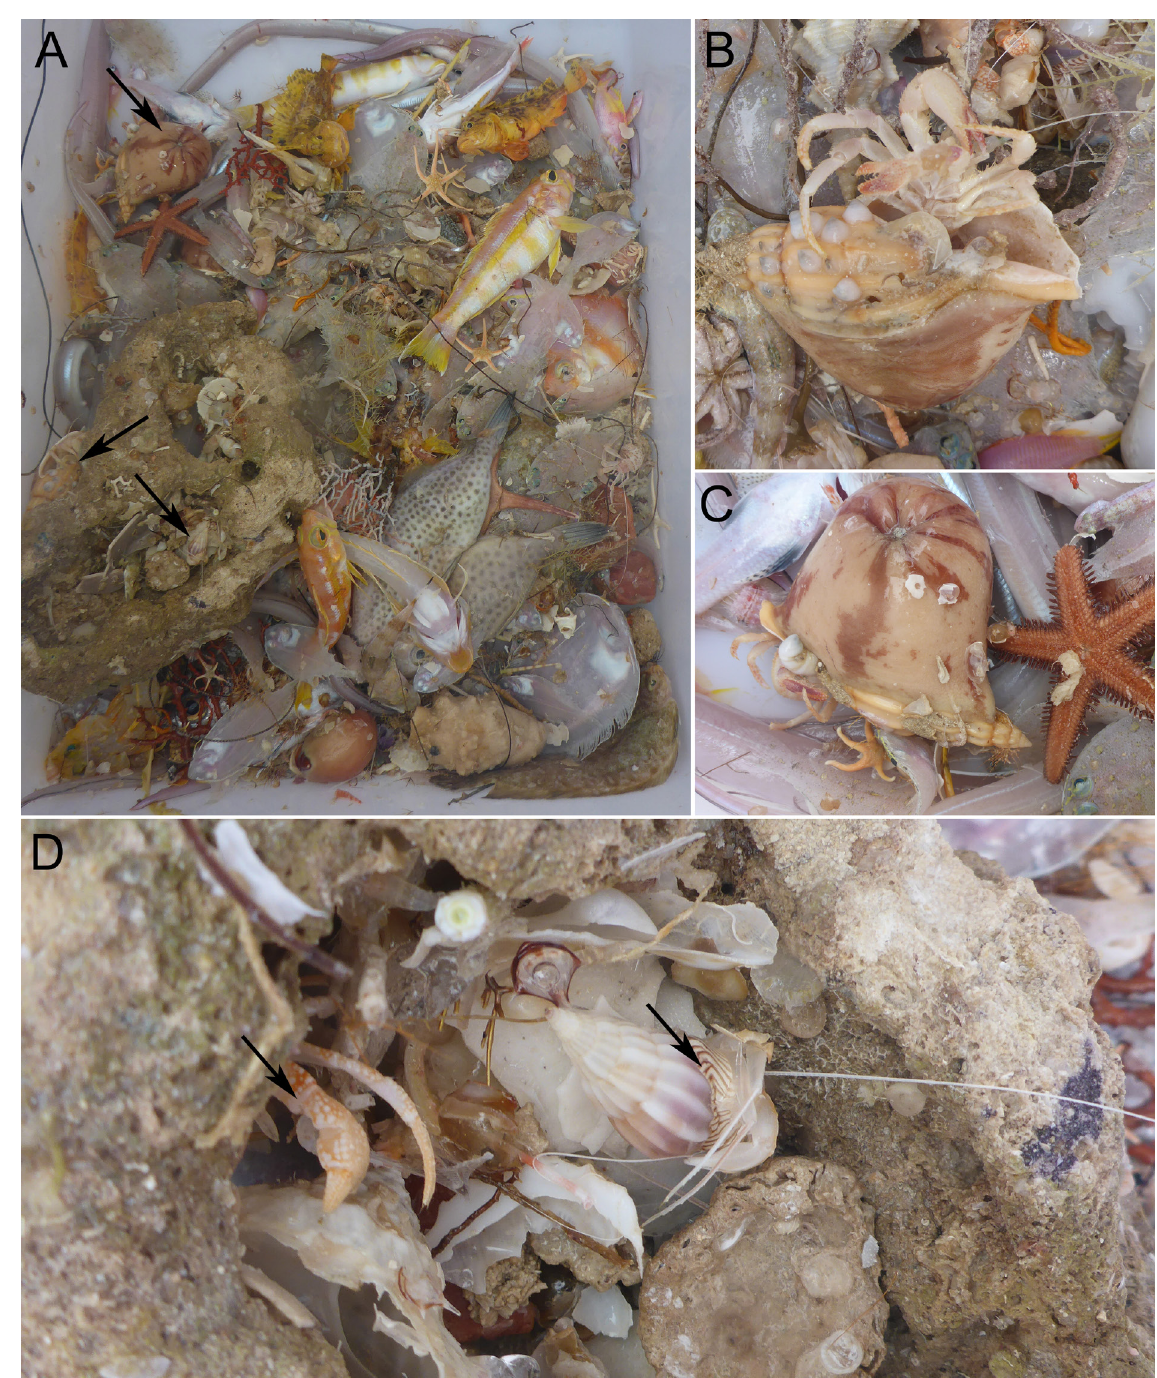
Fig. 5. Bottom trawl haul contents of KANADEEP Sta. CP4958 (Argo Bank), collection locality of one of the paratypes of Aretopsis sandybrucei sp. nov. A . General view of haul contents, with black arrows pointing to several hermit crabs (Paguridae). B – C . Hermit crab, possibly Diacanthurus sp. (Paguridae), carrying a large gastropod shell also harbouring a sea anemone. D . Two hermit crabs of the family Paguridae. Photographs by Dr Sarah